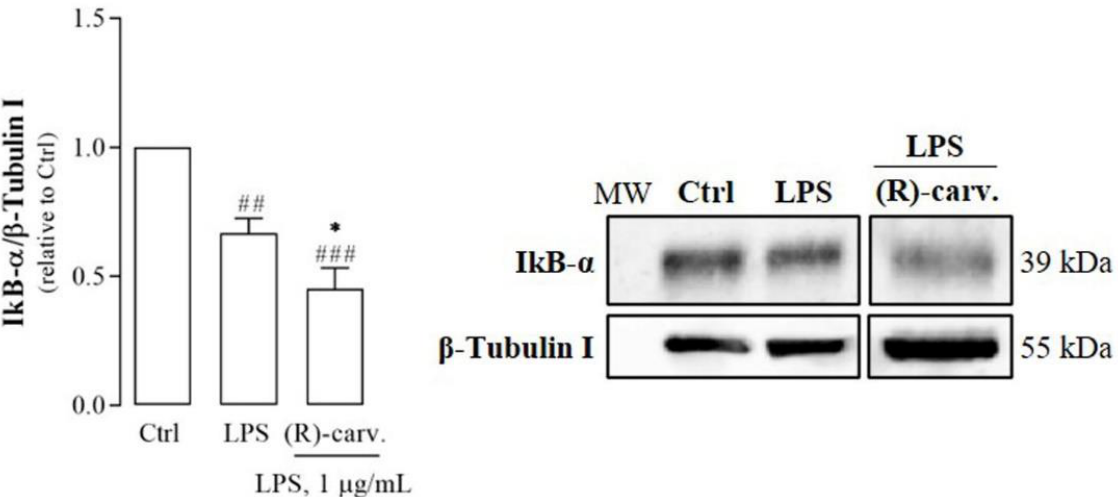
Figure 5. LPS-induced I κ B- α resynthesis is inhibited by (R)-(-)-carvone. Cell cultures were pre- treated with the vehicle (0.1% DMSO) or 665 µ M (R)-(-)-carvone for 1 h, followed by stimulation with 1 µ g/mL LPS for 1 h. Control cells (Ctrl) were treated with the vehicle (0.1% DMSO) alone. Each column represents the mean ± SEM of seven independent experiments. Representative images are shown. The corresponding images of the full-length blots are shown in Supplementary Figure S1. * p < 0.05 relative to LPS-treated cells. ## p < 0.01 and ### p < 0.001 relative to the Ctrl. MW: molecular weight marker.